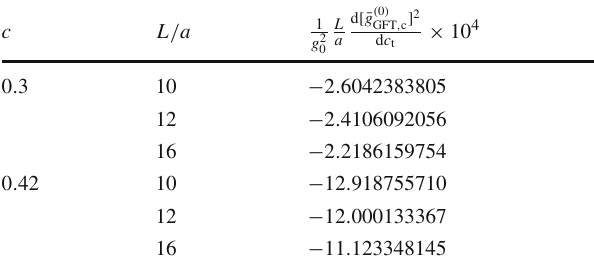
Table 6 Results for the c t -derivative of the GFT-coupling at tree-level in lattice perturbation theory. The results refer to the magnetic cou- pling discretized using the Zeuthen flow and O( a 2 )-improved plaque- tte + clover definition of the flow energy density